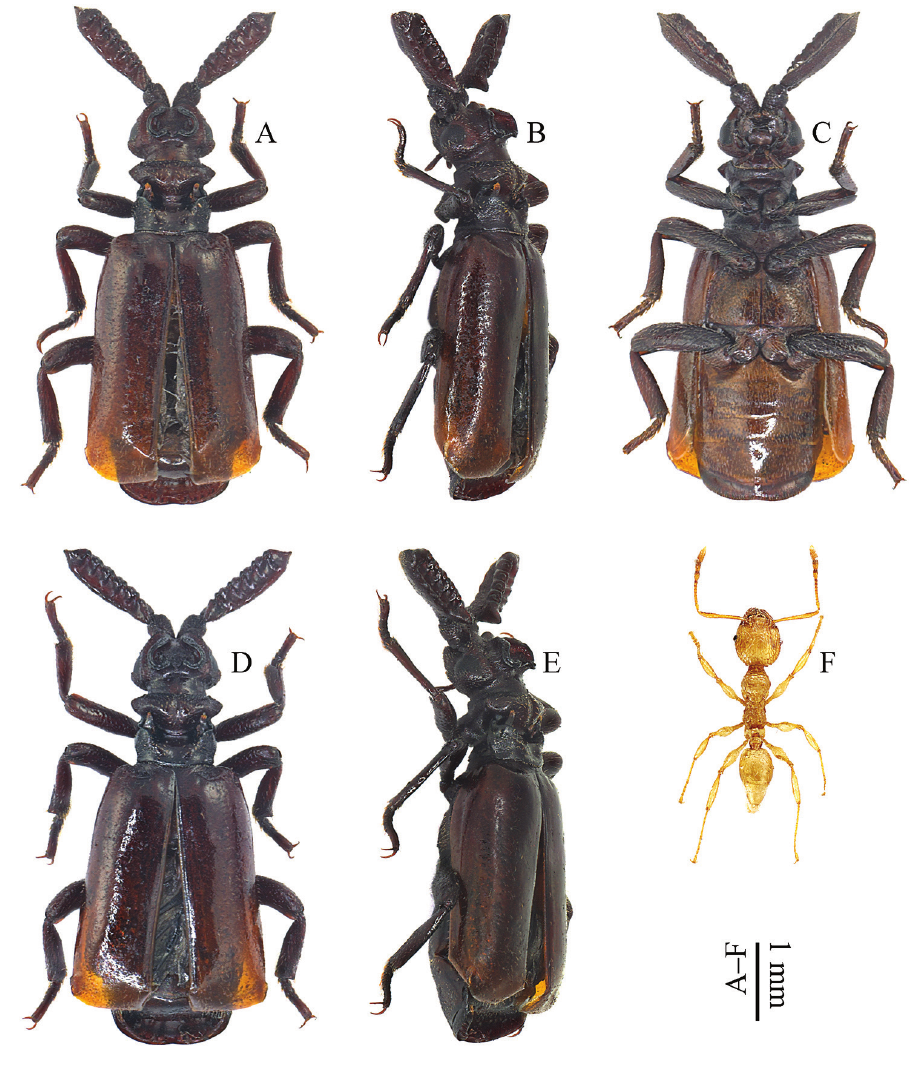
Figure 2. Habitus of Paussus ( Scaphipaussus ) zhouchaoi sp. n. ( A–C holotype, ♂ D–E paratype, ♀ ) and its host ant ( F Pheidole sp., minor worker) A, D, F dorsal view B, E dorsolateral view C ventral view. II combined. Ligula large and broad, with apical margin broadly rounded at middle. Gula with width/length (at narrowest point) =